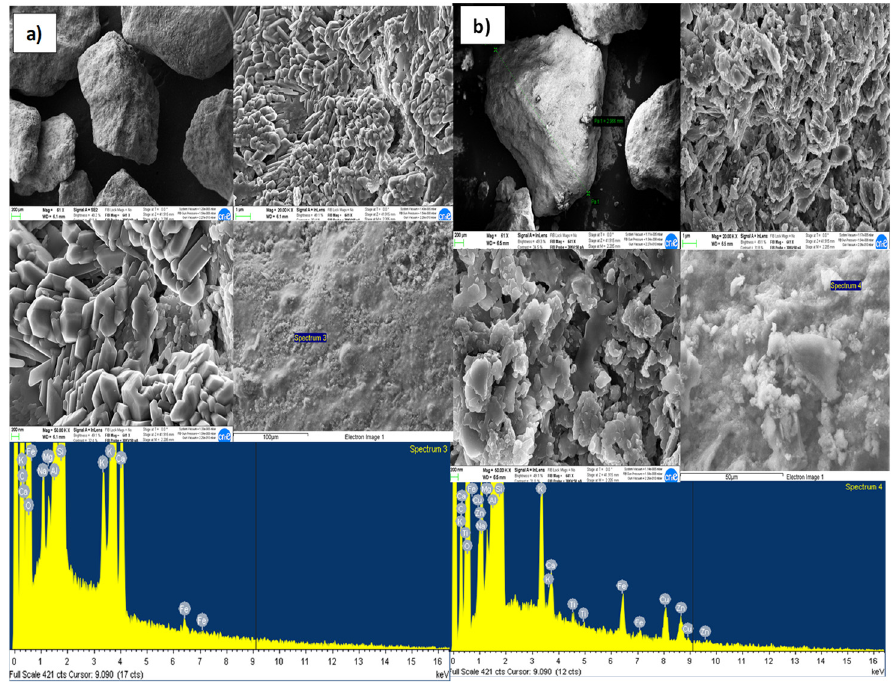
Figure 7. FESEM and EDX microphotographs of the clinoptilolite natural zeolite ( a ) Inlet of the column. ( b ) Outlet of the column.